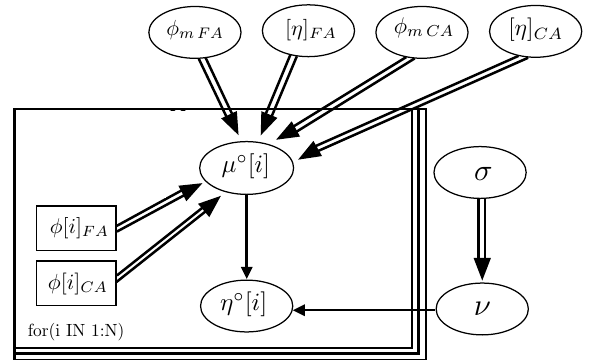
Figure 9. Graph of the Bayesian network of the Krieger–Dougherty equation in self-compacting